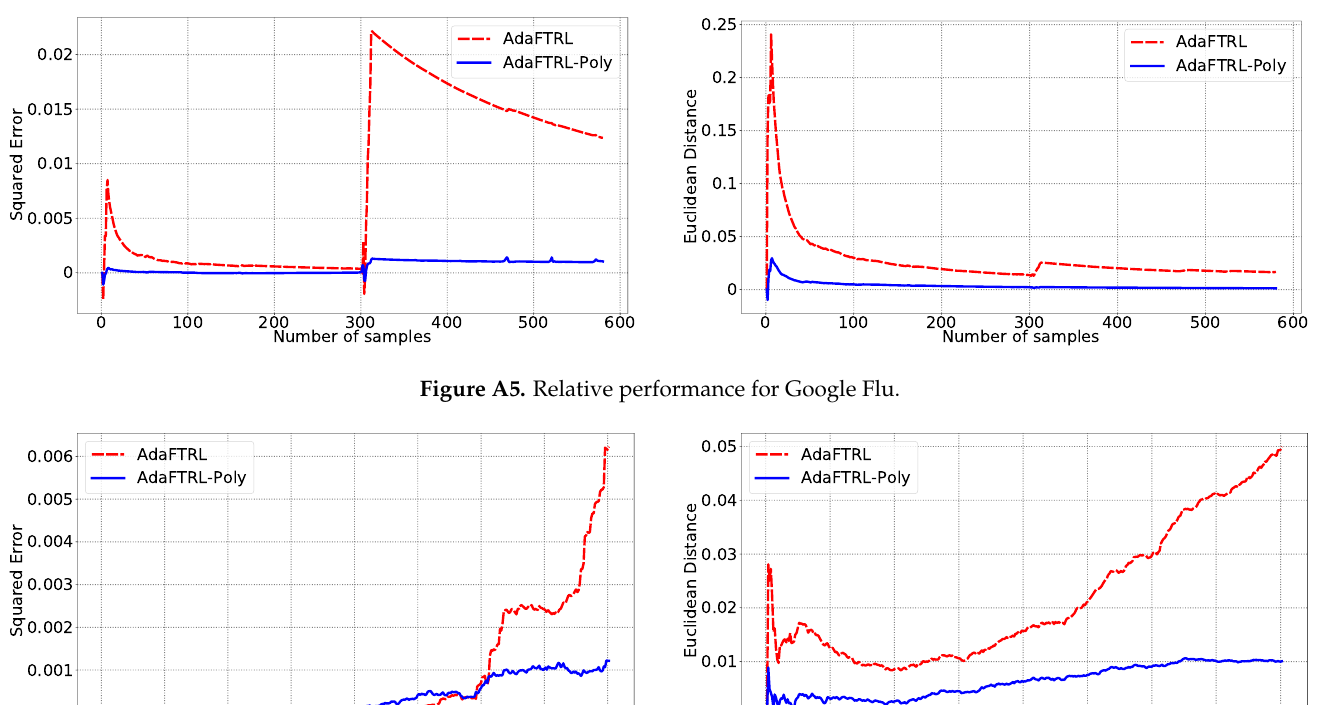
Figure A4. Relative performance for stock data.